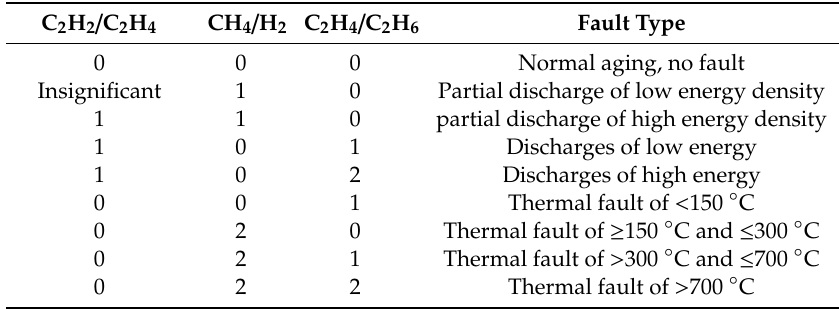
Table 3. Fault classification using International Electrotechnical Commission (IEC) ratio